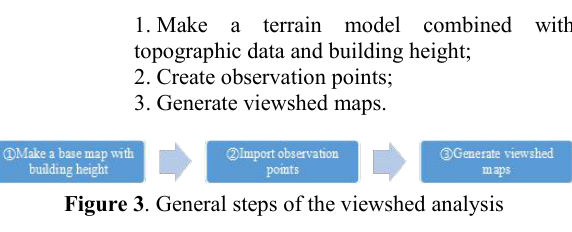
Figure 3 . General steps of the viewshed